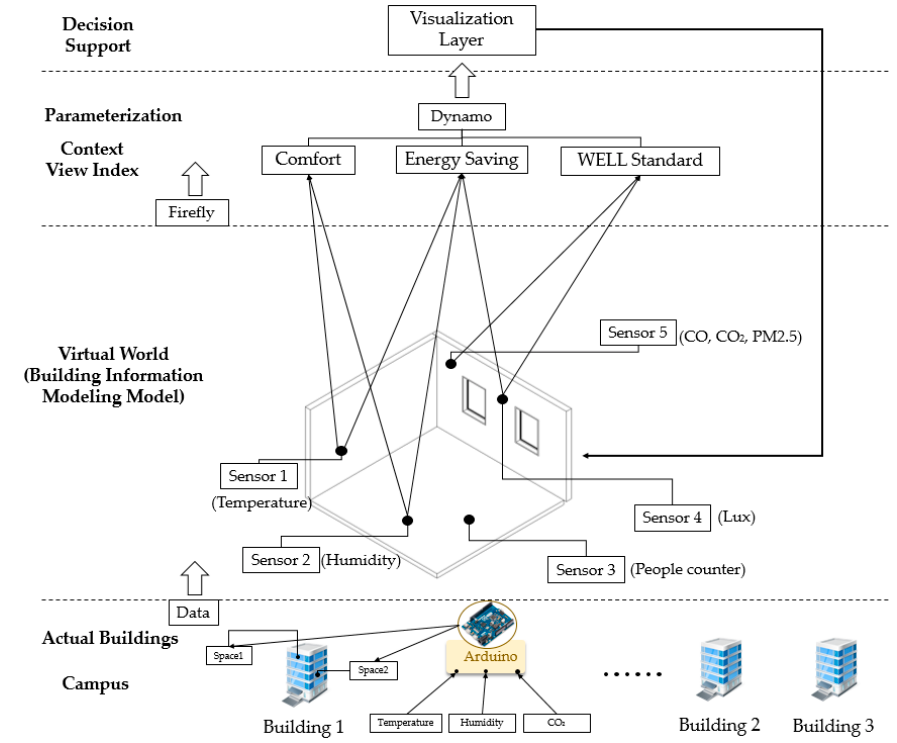
Figure 1. Visualization framework.